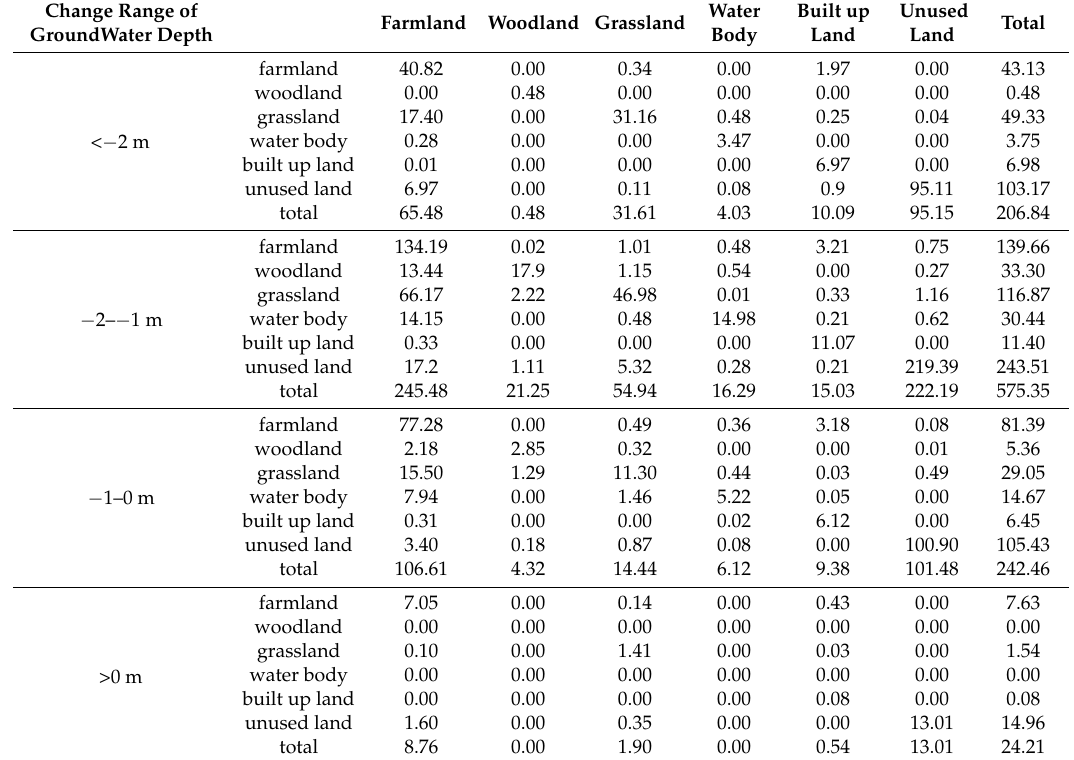
Table 8. The transition matrix of land use types with respect to different change range of groundwater depth between 1985 and 2010 (km 2